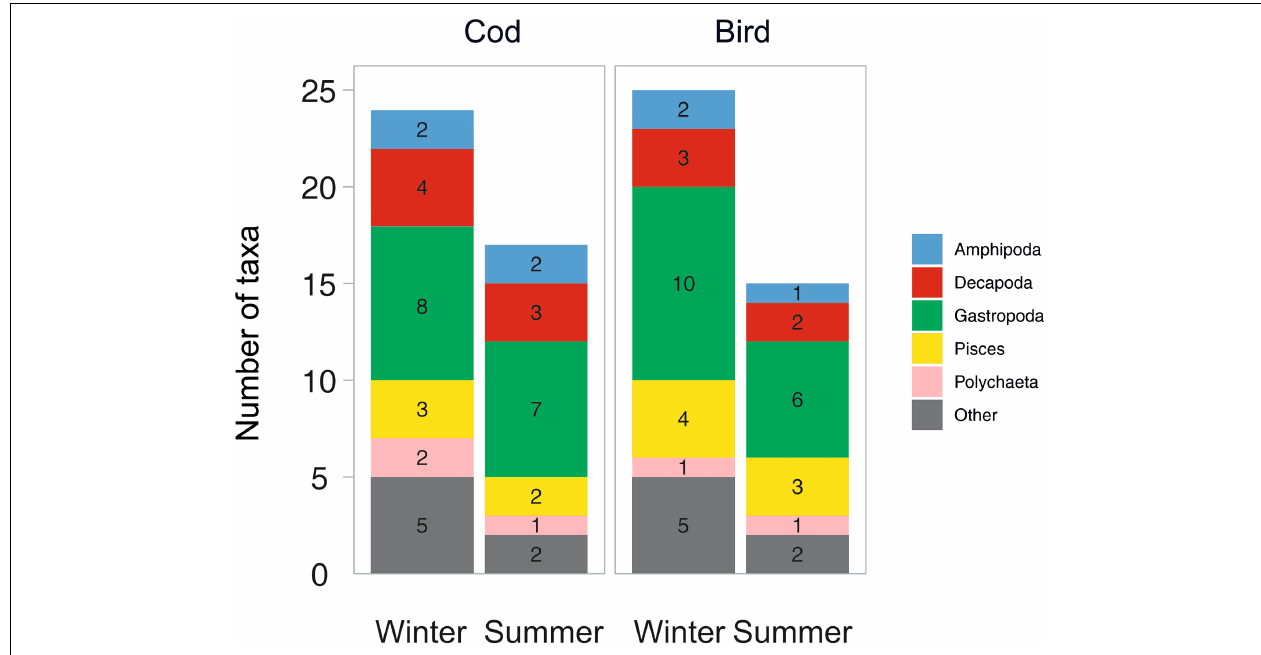
FIGURE 5 | Number of taxa recorded at two bait types in each of two seasons.